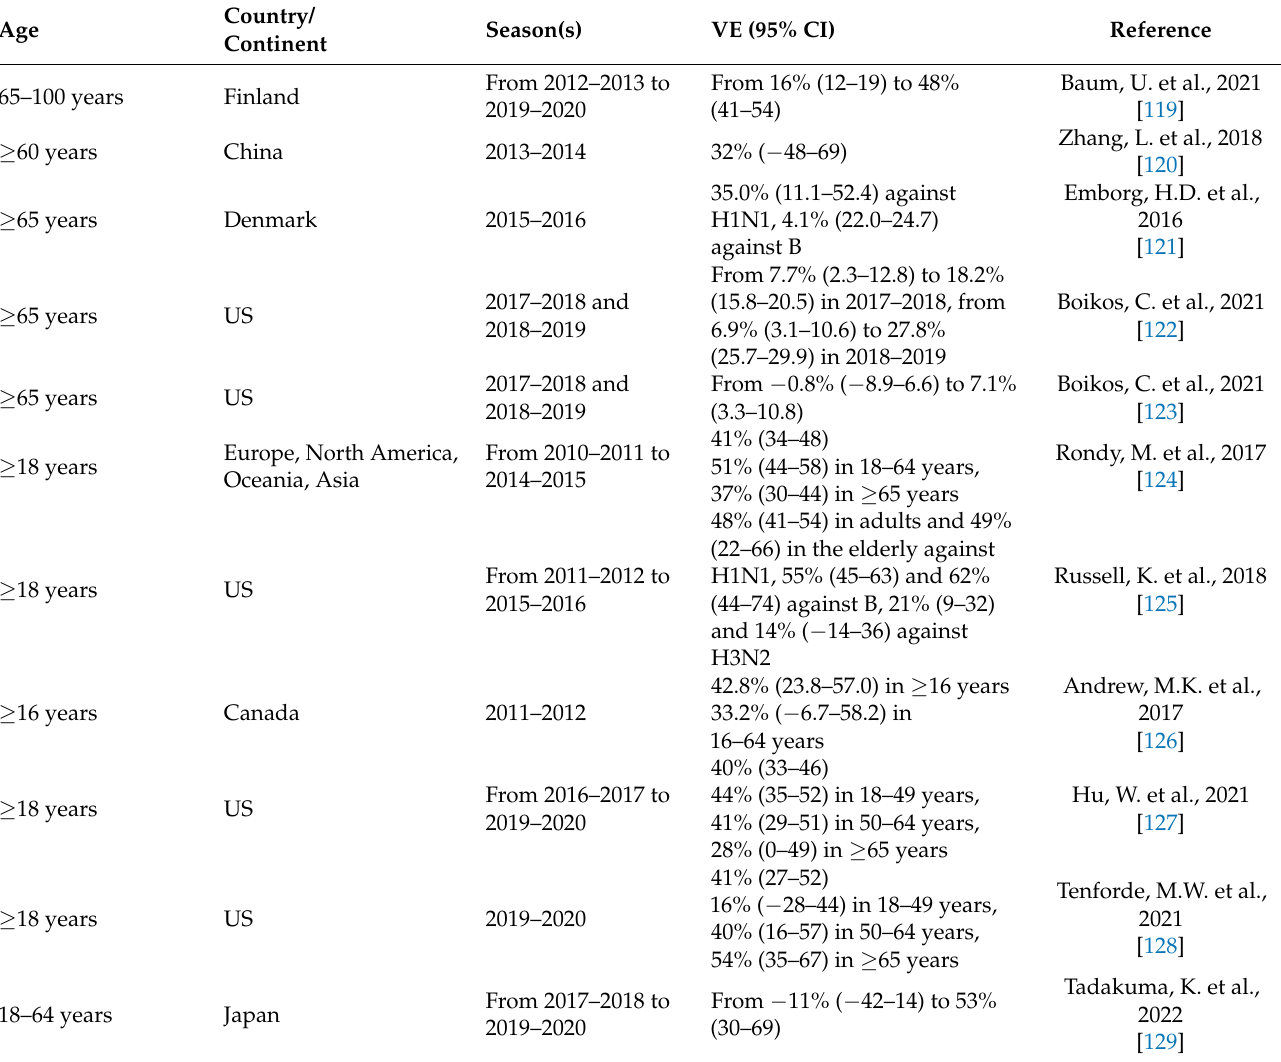
Table 3. Overview of studies on VE conducted in adults and the